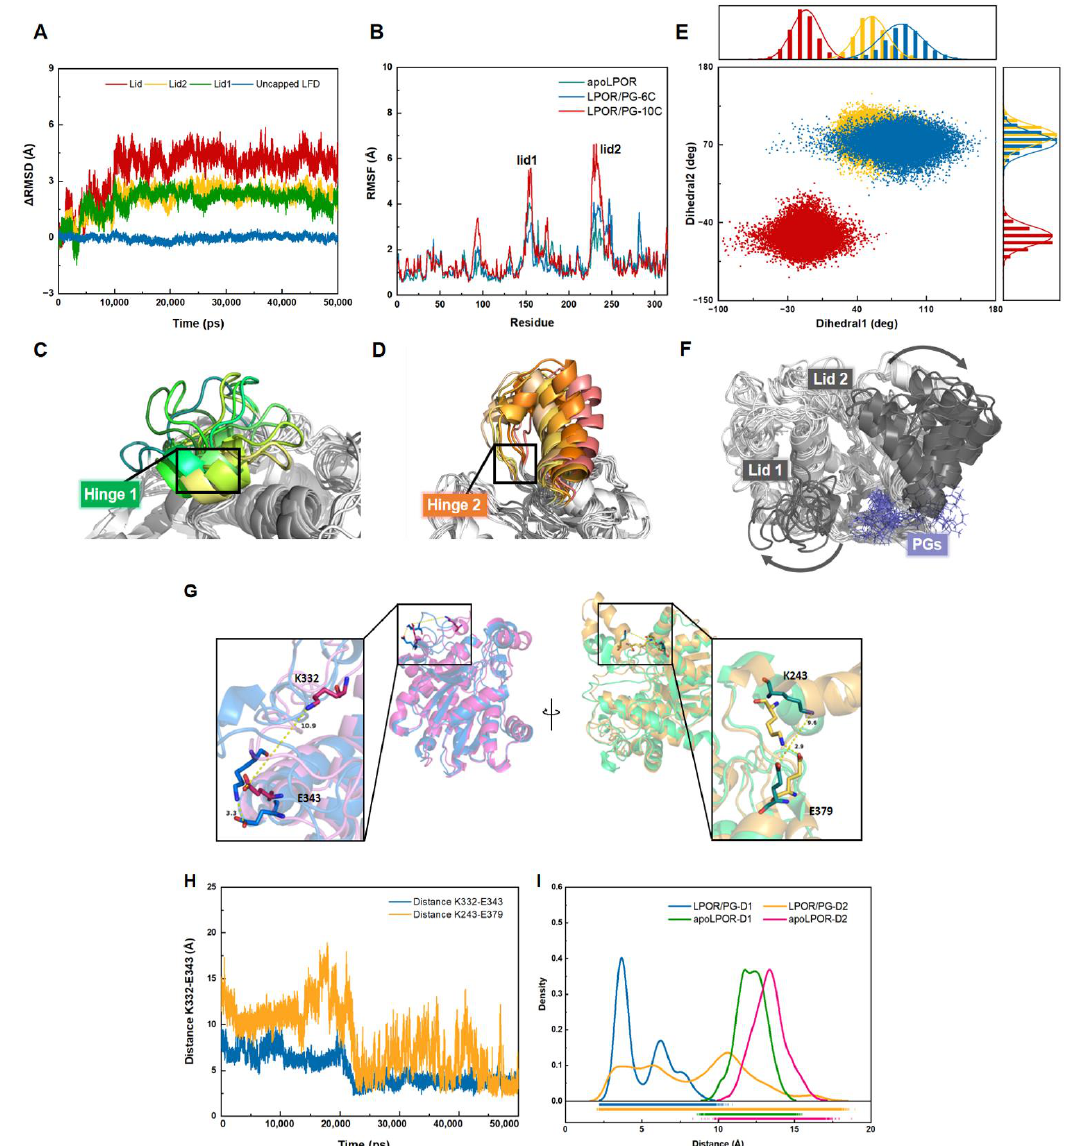
Figure 6. ( A ) Changes in the RMSD values of the lid relative to the RFD domain in the LPOR/PG structure during the simulations. ( B ) RMSF plots of all the atoms of LPOR/PG and apoLPOR. Structure data of lid1 ( C ) and lid2 ( D ) colored according to the opening pathway progress from yellow to green and orange to red, respectively. ( E ) Sampling of variables quantifying the lid position in aMD simulations of closed (red), open (blue) apoLPOR, and the open LPOR/PG (orange) systems. Dots represent MD snapshots in the last 20 ns runs. The variables are defined as two dihedral angles, representing the flipping of the I229-T230-G231 and 310I-311A-312T rotary microswitches in the hinge region. The details are shown in Figure S16. ( F ) The integral opening process shown to emphasize the hinge and lid motion in the simulated close LPOR structure, viewed from above. The black arrows display the movement direction of the lid in the simulations with respect to the inactive closed state. ( G ) Switching of the two salt bridges in the representative conformations of the LPOR/PG systems. The yellow dotted line represents the length of the salt bridge. ( H ) Comparison of the distances between the N atom in the side chain of K243/332 and O atom in the side chain of E379/343 for the LPOR/PG systems. ( I ) Distributions of distances 1 and 2 of Lys332-Glu343 and Lys243-Glu379 during the 50 ns simulation time for closed apoLPOR and LPOR/PG. The green, pink, blue, and yellow solid lines denote D1 and D2 in the closed crystal structure (PDB ID: 7JK9) and open structure of LPOR, respectively.